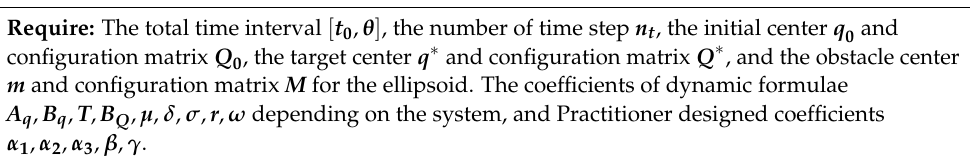
Algorithm A1. Numerical Solutions for Theorem